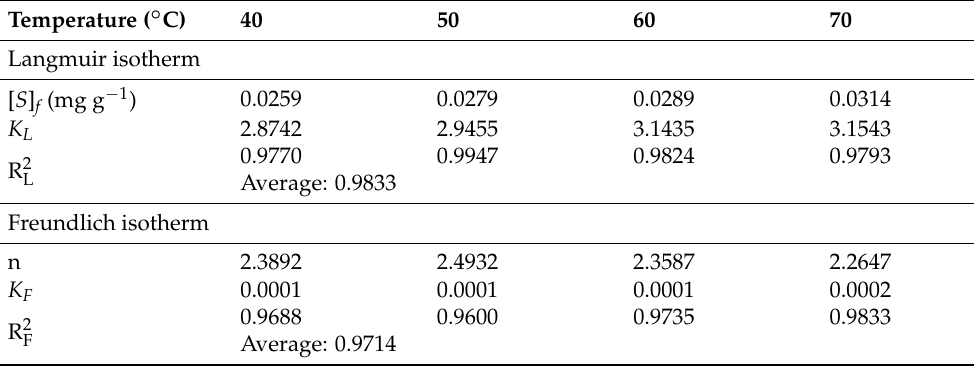
Table 4. Parameters of Langmuir and Freundlich isotherms of dyeing of raw ramie yarn with Reactive Blue 194 in water